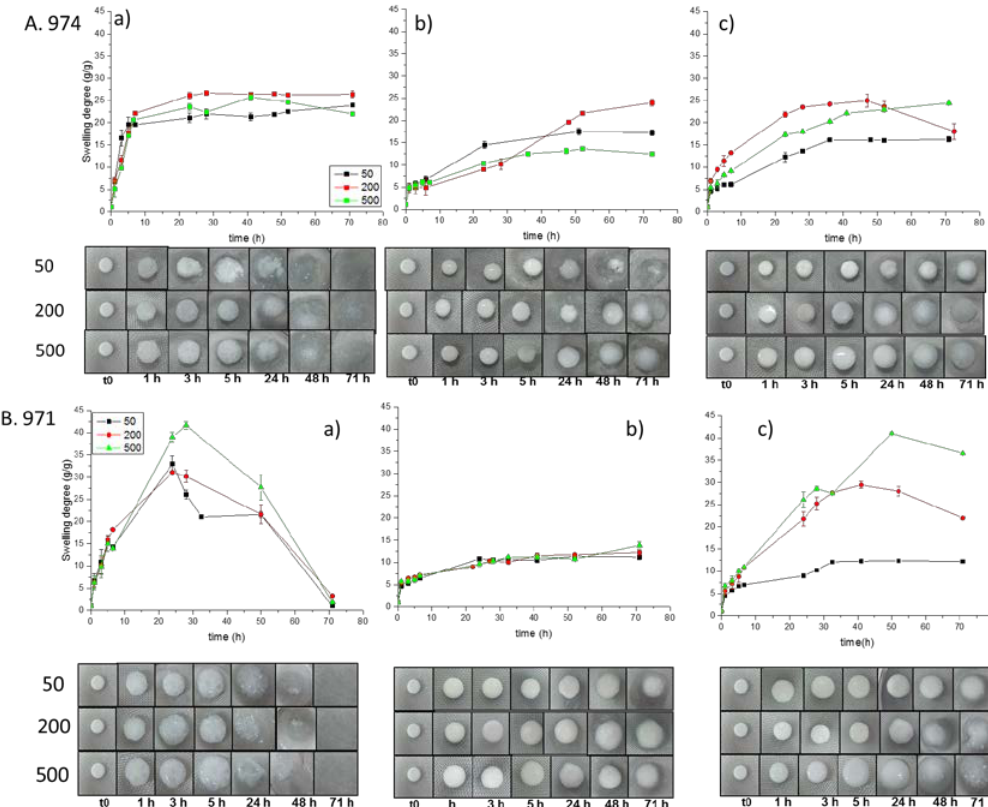
Figure 5. Swelling degree and photographs of the tablets of Carbopols/Poly(2-ethyl-2-oxazoline)s in saliva at 37 °C at regular time intervals: ( a ) physical mixture; ( b ) interpolymer complexes formed in water; and ( c ) interpolymer complexes formed at pH 2 (A Carbopol 974; and B. Carbopol 971).